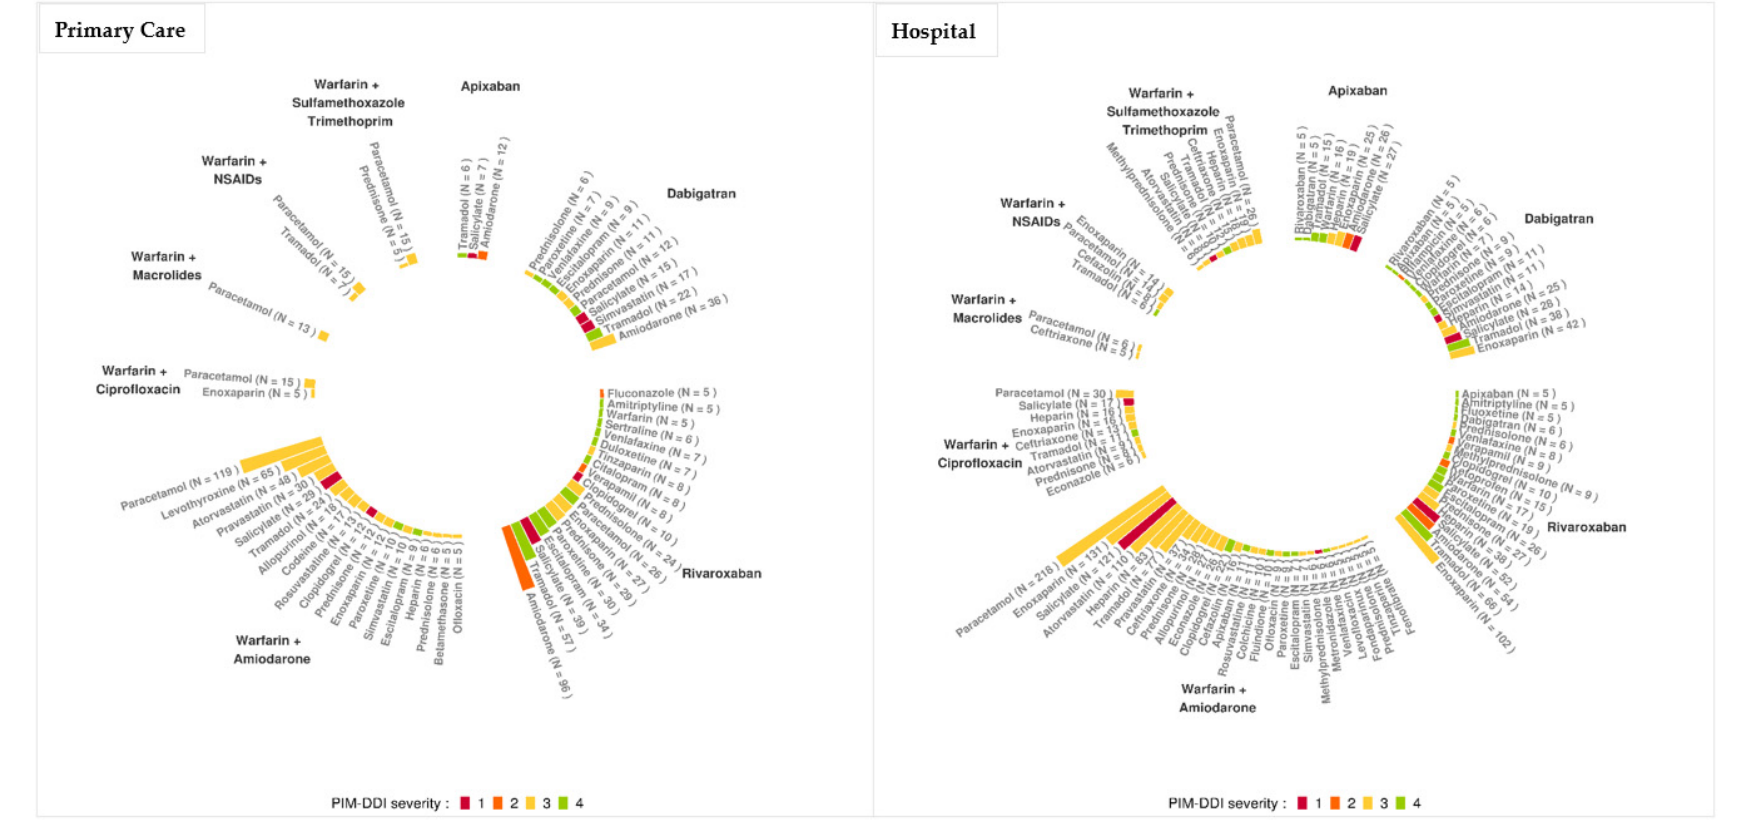
Figure 2. Ranking of the drugs involved in PIM–DDI in hospitalized patients treated by oral anticoagulants in primary care and/or during their hospitalization. Levels of severity: Contraindicated (1, red), not recommended (2, orange), use with caution (3, yellow) and to take into account (4, green).